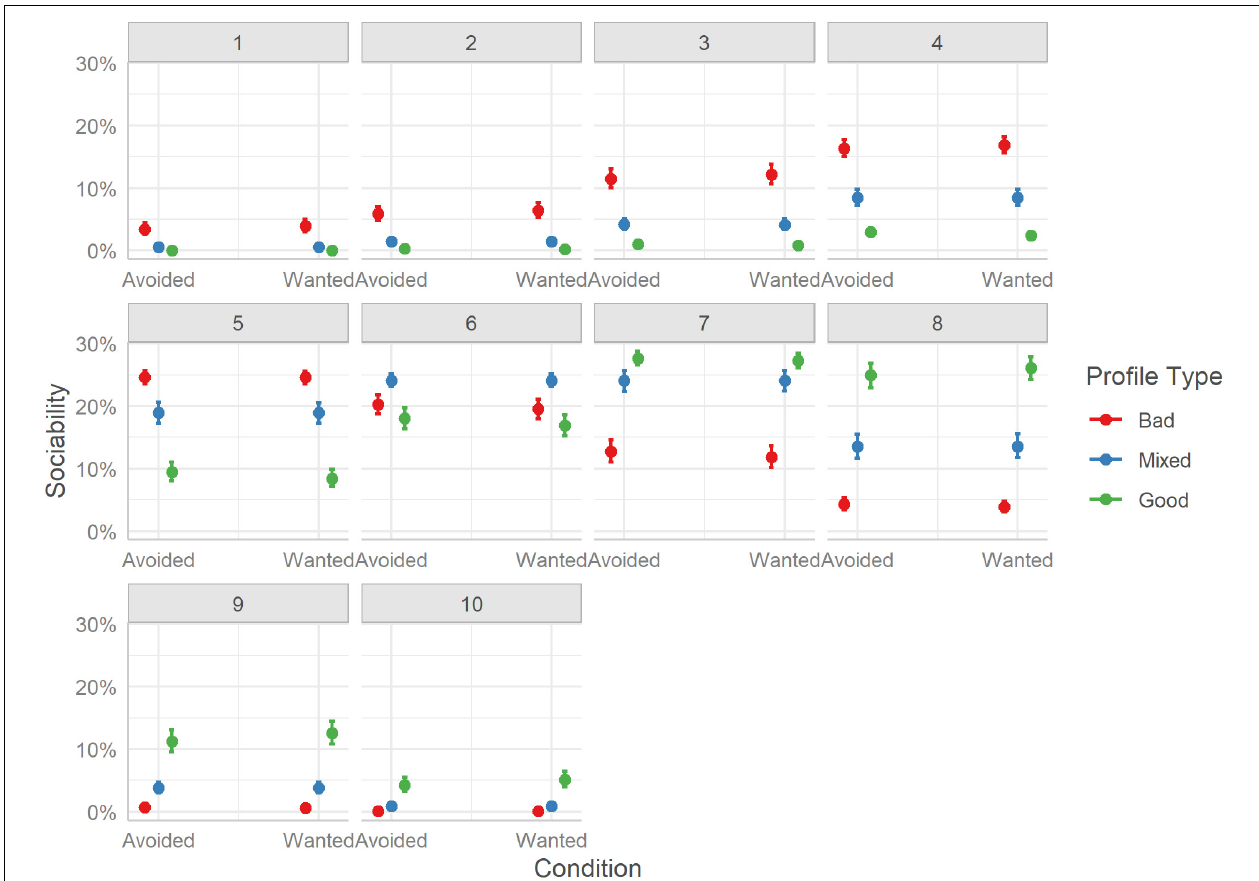
FIGURE 13 | Marginal effects of sociability. The posterior mean estimates of the probability of responses in each of the three Profiles (Bad, Good, Mixed) by the two experimental Conditions (Avoided or Wanted). Error bars indicate 95% credible intervals.